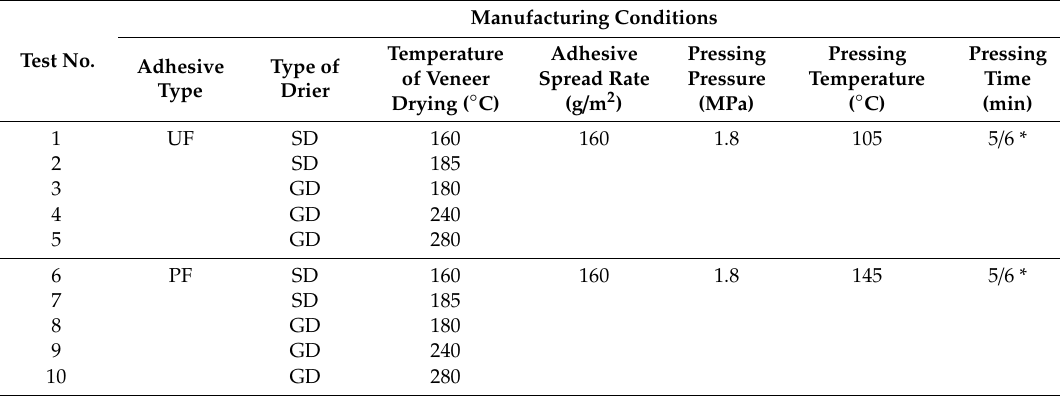
Table 2. Conditions of manufacturing three-layer plywood